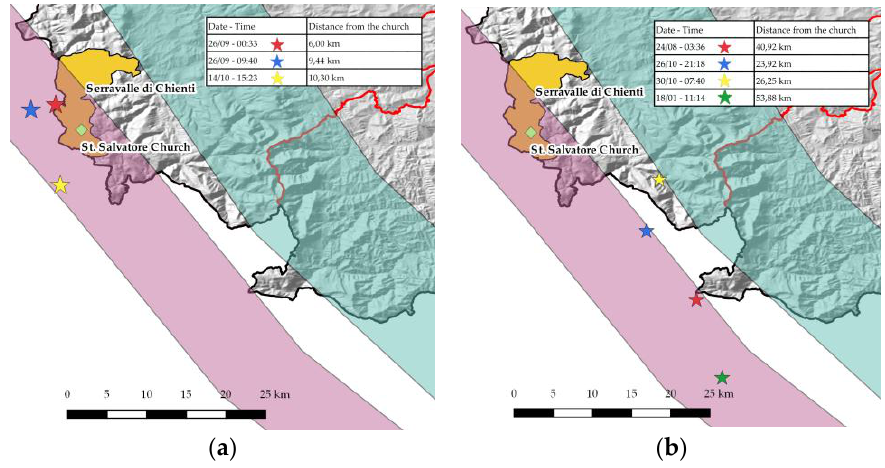
Figure 20. Maps showing the distances of epicenters of the principal shocks from the church. ( a ) The map presents the 1997 Umbria-Marche earthquake shocks. Data source: [41,53–55]. ( b ) This map shows the 2016 Central Italy earthquake shocks. Data source: [41,58–61].